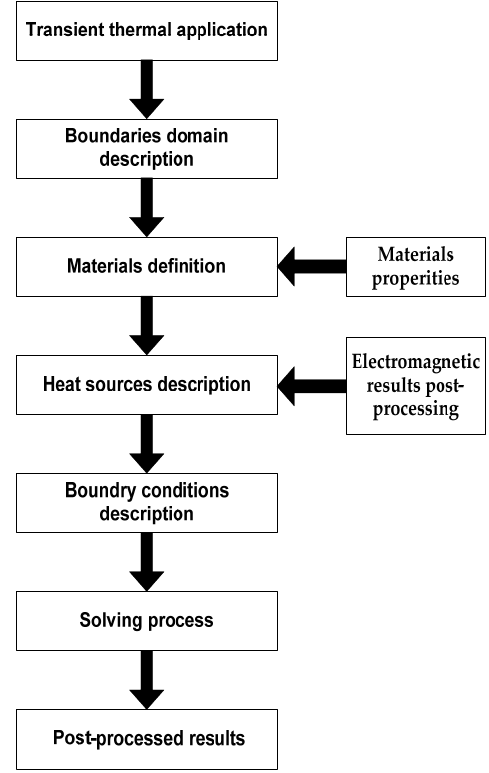
Figure 6. Transient thermal application flowchart.